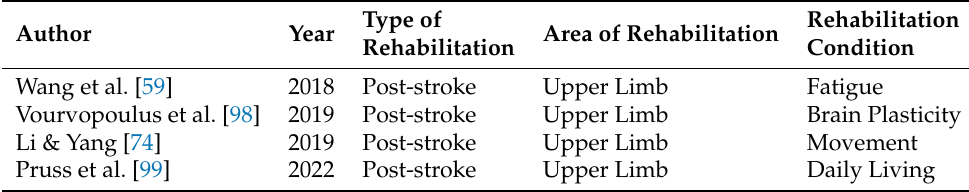
Table 6. Brain–computer interfaces with virtual